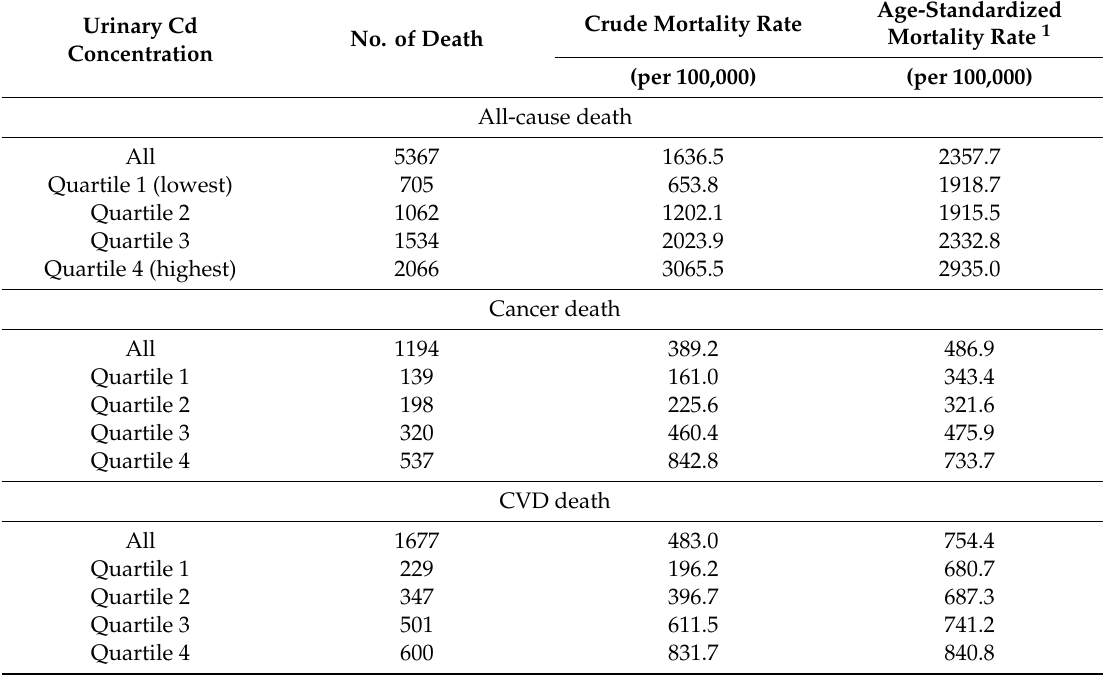
Table 2. Age-standardized mortality rates (ASMRs) of all-cause, cancer and CVD among US adults